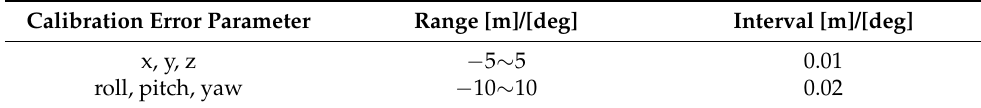
Table 1. Calibration parameter error configuration for Monte Carlo